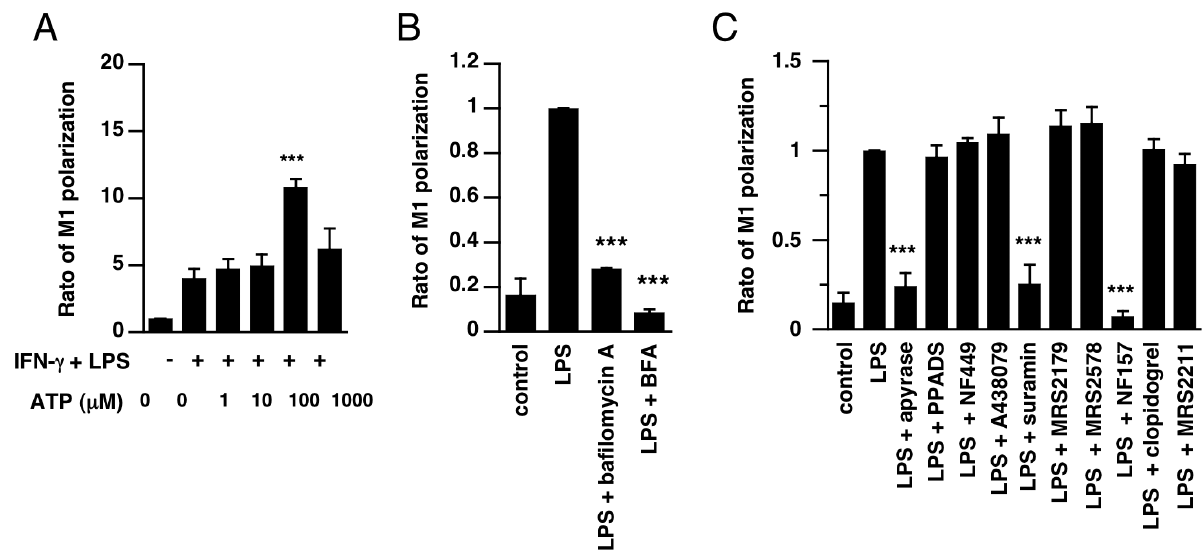
Figure 3. Extracellular ATP contributes to M1 macrophage polarization via activation of P2 receptors. ( A–C ) THP-1 cells were cultured for 24 h in medium or in medium supplemented with LPS and IFN-gamma in the absence or presence of ATP ( A ), or bafilomycin A (50 nM), BFA (10 m M) ( B ), apyrase (25 U/mL), PPADS (100 m M), A438079 (100 m M), suramin (100 m M), NF449 (10 m M), MRS2179 (100 m M), MRS2578 (10 m M), NF157 (50 m M), clopidogrel (30 m M), or MRS2211 (100 m M) ( C ). Expression of M1 macrophage marker CCR7 was measured by flow cytometry. The supernatants were assayed for IL-6 (n=8–10). Each value represents the mean 6 SE. A significant difference between the control group (non-treated or LPS alone) and a test group is indicated by ***(p , 0.001).